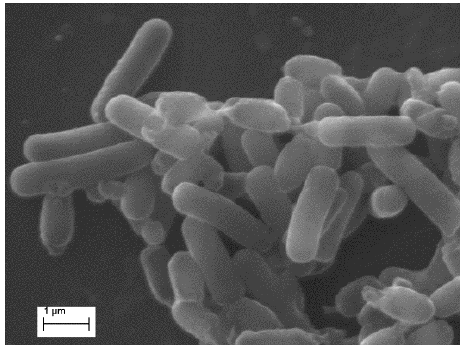
Figure 1. Scanning electron microscope image of strain JAT-1.